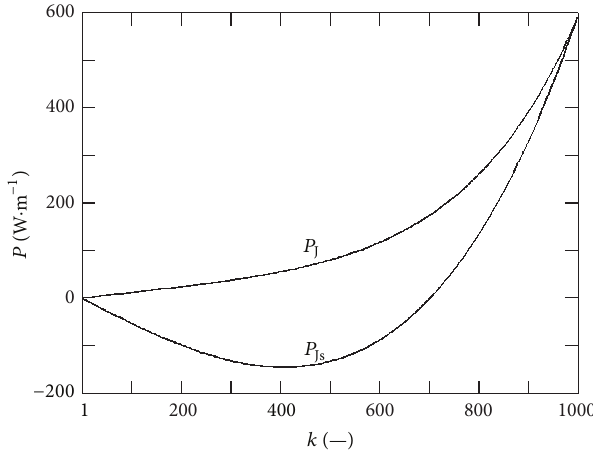
Figure 5: Dependence of 𝑃 conductors in Example 1, for 𝑓 = 10 3 Hz, 𝑛 = 1000 .